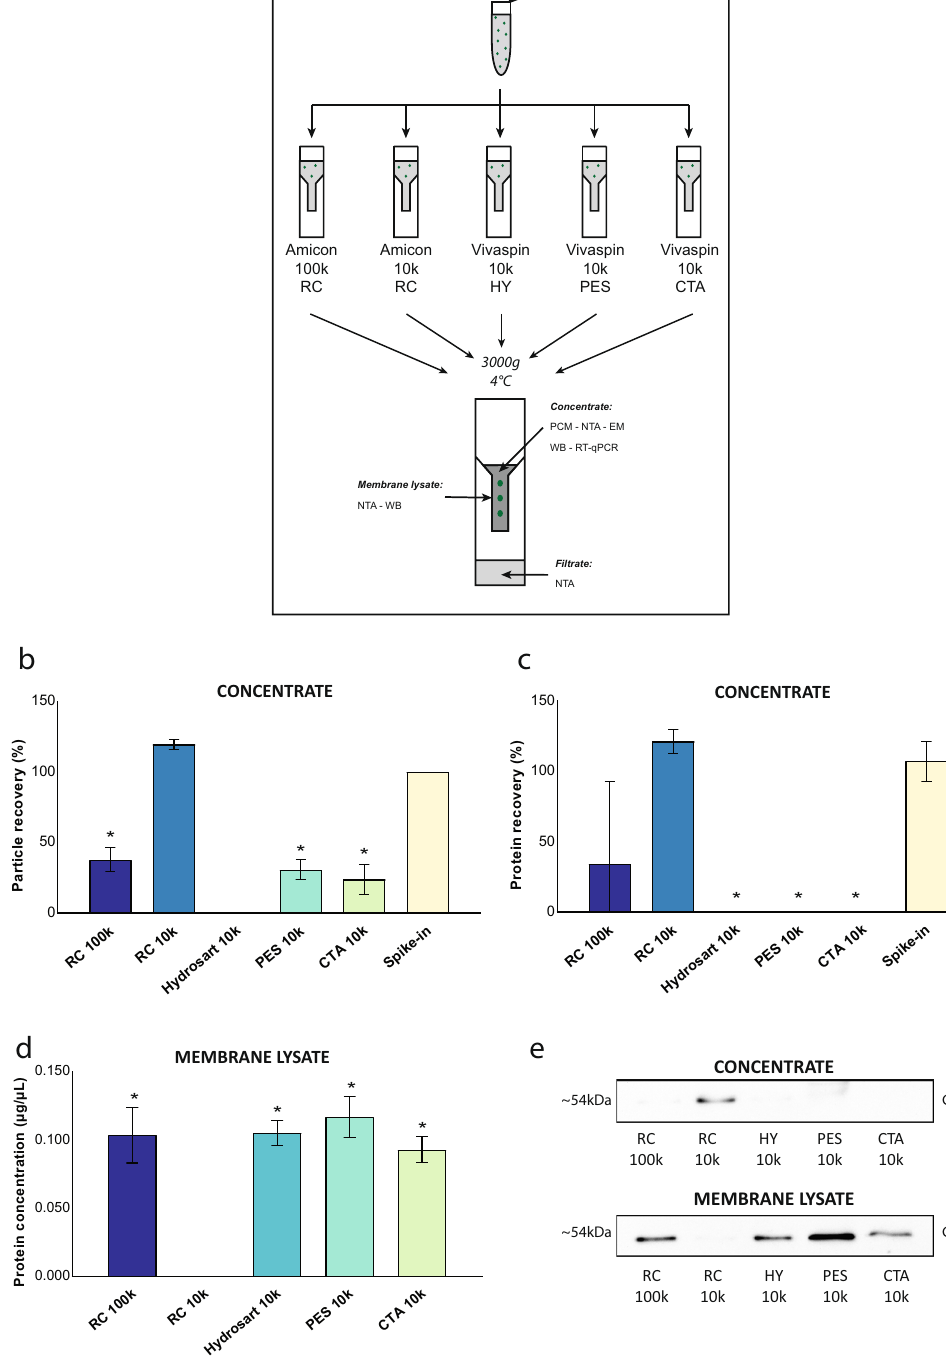
Figure 1. Comparative analysis of centrifugal filters for protein and particle recovery of EVs in PBS. ( a ) 2 mL PBS spiked with GFP-positive EVs was centrifuged at 3,000 g. Concentrate and filtrate were collected. Lysates of filter membranes were used for analysing retained proteins. ( b ) Particle recovery was analyzed using Nanoparticle tracking analysis (n = 3, * p < 0.0001). ( c ) Protein recovery was assessed based on protein concentration measurements (n = 3, * p < 0.0001). ( d ) Retained proteins on the filter membrane were quantified (n = 3, * p < 0.0009). ( e ) Lysates were used for Western blot immunostaining for GFP. Mean values + SD are indicated. Significant differences were calculated using Student’s t-test with RC 10k as reference. Original immunostaining results are shown in Supplementary Fig. 10. Abbreviations: PBS: phosphate buffered saline. GFP: green fluorescent protein. EV: extracellular vesicle. RC: regenerated cellulose. HY: Hydrosart. PES: polyethersulfone. CTA: cellulose triacetate. WB: Western blot. NTA: Nanoparticle tracking analysis. PCM: protein concentration measurement. RT-qPCR: real time quantitative polymerase chain reaction. EM: electron